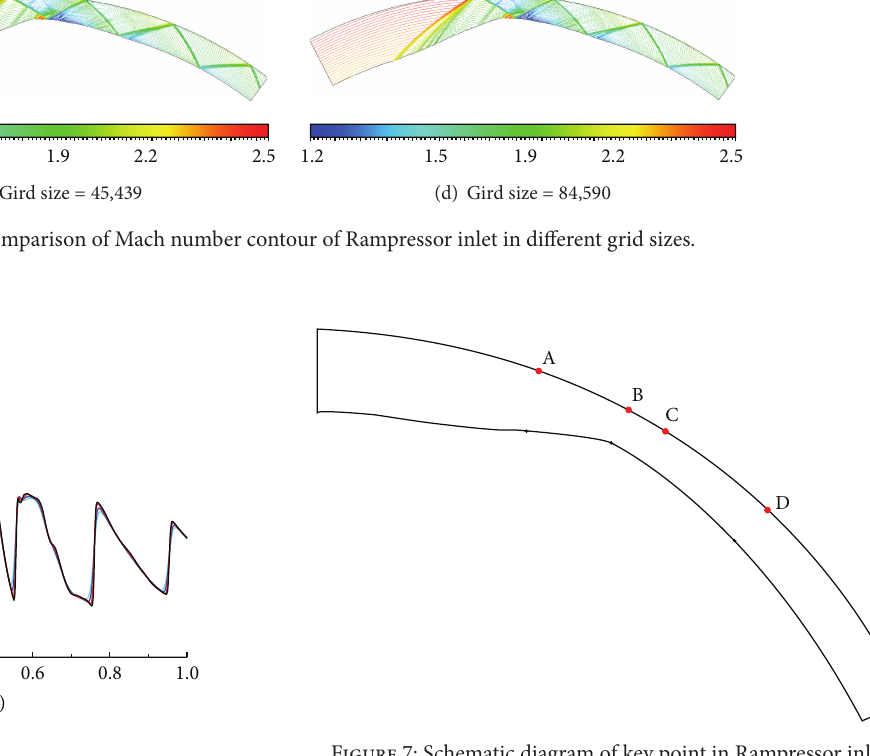
Figure 7: Schematic diagram of key point in Rampressor